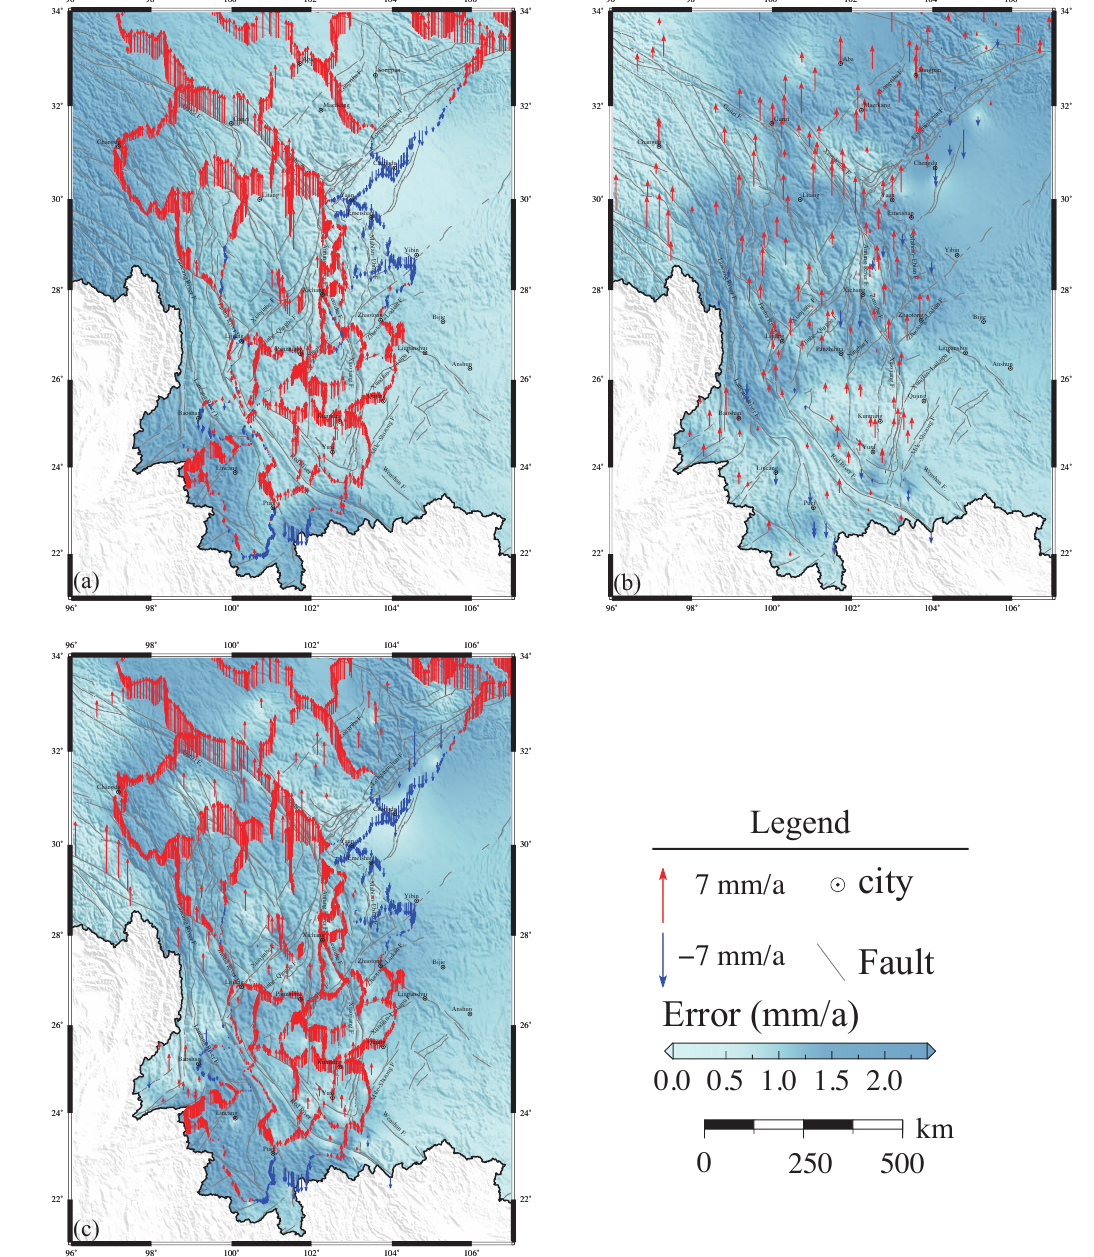
Figure 2. The vertical motion vectors of the SYR obtained ( a ) from the leveling data, ( b ) from the GNSS data, and ( c ) by fusing the leveling and GNSS